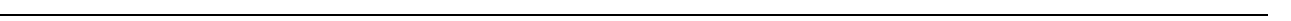
Fig. 5 Deletion of Notch1 results in regression of cell alignment, compromised cell – cell junctions, and enhanced proliferation. a Schematic to illustrate time line for in vivo model of inducible deletion of endothelial Notch1 ( Notch1 ECKO ). Cre + Notch1 loxP/loxP mice after 8 weeks of age received three intraperitoneal injections of tamoxifen as did age-matched control mice at speci fi ed time points. b Notch1 transcript levels from descending aortae of adult WT mice and Notch1 ECKO mice 2 weeks post tamoxifen measured by qPCR analysis ( n = 12 WT and n = 5 Notch1 ECKO ). T- test ****P < 0.0001. c En face confocal imaging of the endothelium of the descending aorta for Notch1 ECKO , 1 week post deletion, and control mice (Cre − Notch1 loxP/loxP ); all mice were injected with tamoxifen. Ve-Cadherin revealed instances of endothelial cells oriented perpendicular to blood fl ow direction (highlighted by dashed ovals). Quanti fi cation of cell orientation, measured by elongation factor (cell length along fl ow direction divided by cell width) for Notch1 ECKO vs. control (Cre − Notch1 loxP/loxP ). All mice were injected with tamoxifen and evaluated 1 week later (100 cells were measured from 5 mice for each genotype, T- test **** P < 0.0001). d En face but not in age-matched tamoxifen-injected controls. Determination of fi brinogen was obtained by mean fl uorescence intensity in areas of 500 µ m 2 from fi ve mice of each genotype. Graph bars represent mean ± SEM. T- test * P < 0.05. e Proliferating endothelial cells, as evidenced by the mitotic fi gures